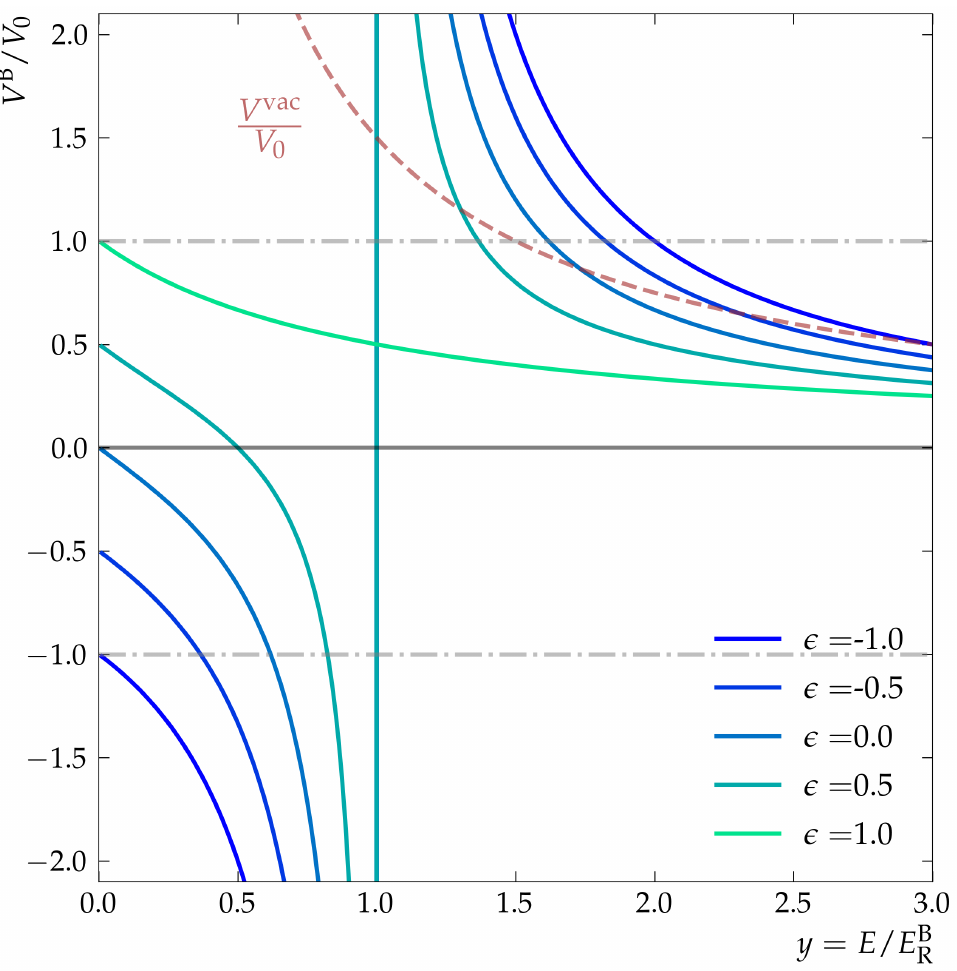
Figure 2 . The dependence of the potential V B /V 0 on energy, y = E/E R , for different values of (cid:15) . Shown also the vacuum kinetic energy V vac /V